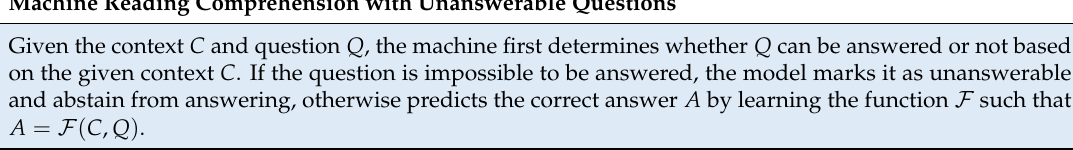
Table 11. Definition of machine reading comprehension with unanswerable questions.